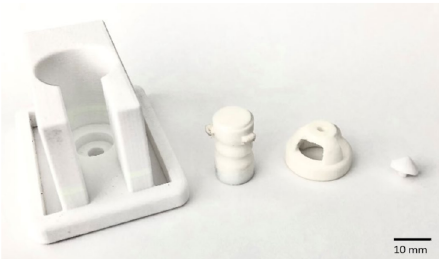
Figure 1. The 3D printed Soft Haptic Biofeedback system: from left, custom housing, the soft bellow pneumatic actuator, the compliant head and an interchangeable tip.